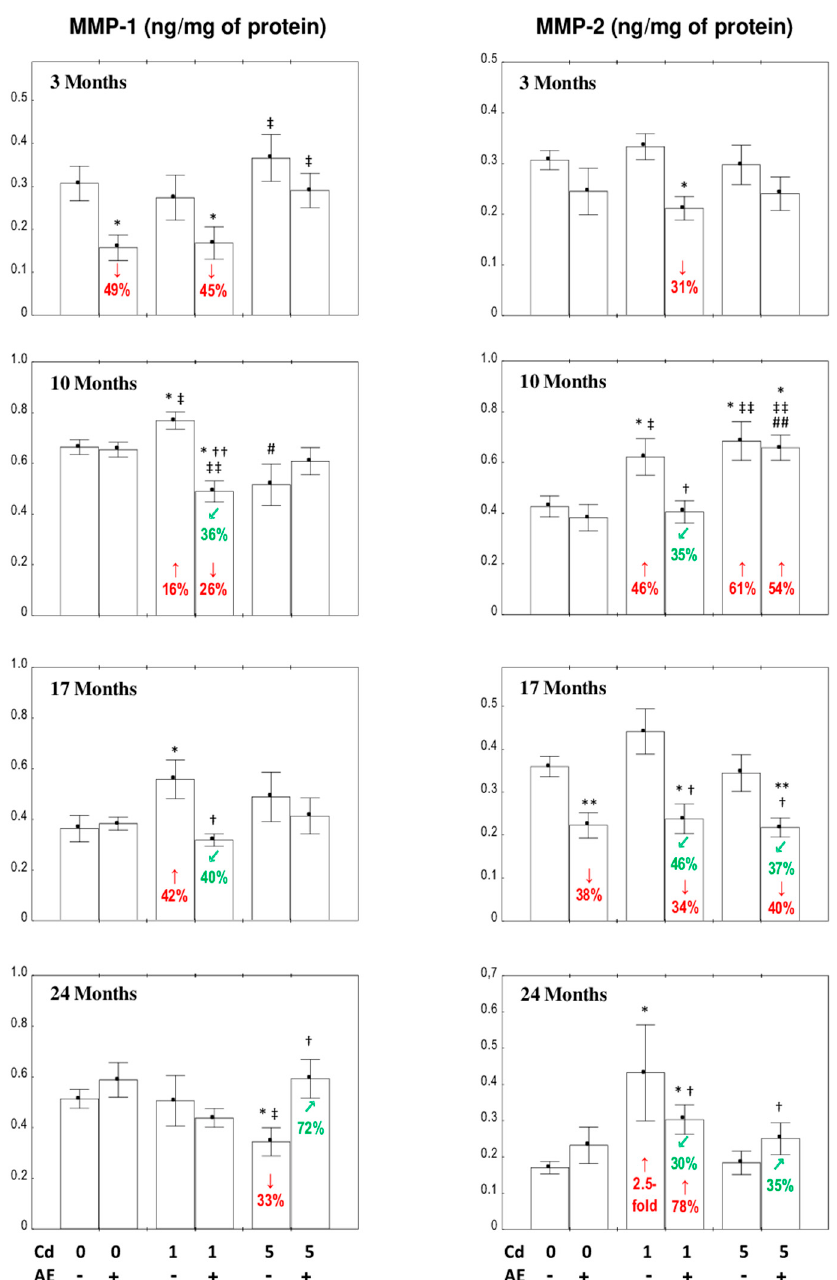
Figure 6. The impact of Aronia melanocarpa L. berry extract (AE) on the concentrations of matrix metalloproteinase-1 (MMP-1) and matrix metalloproteinase-2 (MMP-2) in the livers of rats exposed to cadmium (Cd). The animals were treated with Cd at the concentrations of 0, 1, and 5 mg Cd/kg in their diets and/or 0.1% aqueous AE (+) or not ( − ). Data are shown as mean ± SE for eight rats, except for seven animals in the AE, Cd 1 , and Cd 5 groups after 24 months. Statistically significant differences (Kruskal–Wallis post hoc test): * p < 0.05 and ** p < 0.01 vs. control group; † p < 0.05 and †† p < 0.01 vs. appropriate Cd group; ‡ p < 0.05 and ‡‡ p < 0.01 vs. AE group; # p < 0.05 and ## p < 0.01 vs. appropriate group maintained on the 1 mg Cd/kg diet (Cd 1 group or Cd 1 + AE group). Numerical values in bars express the percentage changes or factors of changes in comparison to the control group ( ↑ , increase; ↓ , decrease) or the appropriate group exposed to Cd alone ( ↗ , increase; ↙ , decrease).